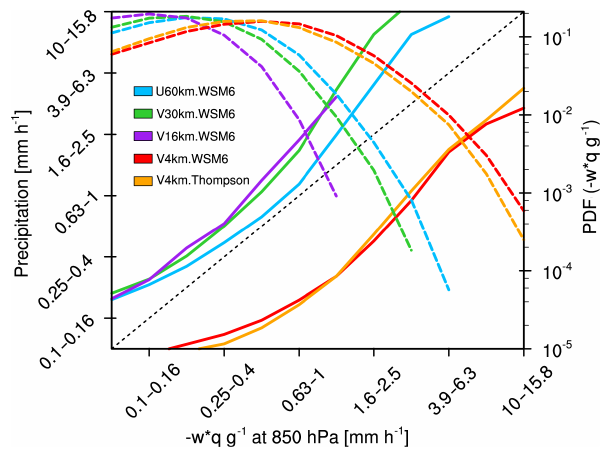
Figure 13. Hourly precipitation versus upward moisture flux at 850hPa during the event over East China (denoted as the black box in Fig. 6) from the MPAS simulations at resolutions of 60, 30, 16, and 4km (solid line, left axis), with the PDFs of the upward mois- ture flux (dashed line, right